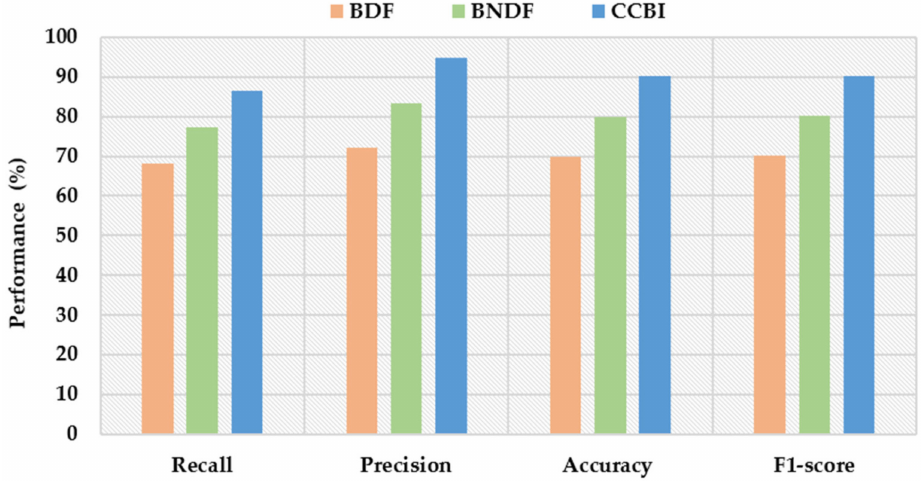
Figure 8. The comparison of the schemes on the four